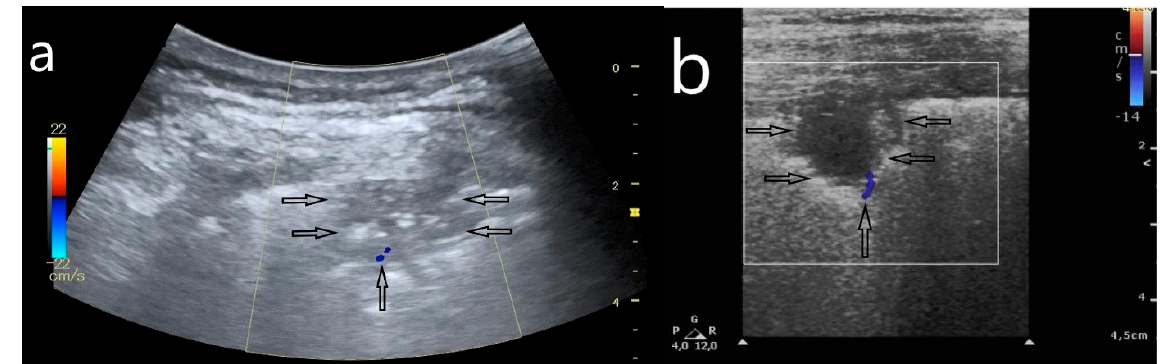
Figure 5. Subpleural consolidation due to pulmonary embolism secondary to COVID-19. ( a , b ) Wedge-shaped subpleural consolidation (horizontal arrows), with a ‘vascular sign’—flow amputation visible in Color Doppler (vertical arrow). Table 1. Incidence of specific LUS findings, depending on the patient group: 1—ambulatory; 2—department of internal medicine; 3—intensive care unit.